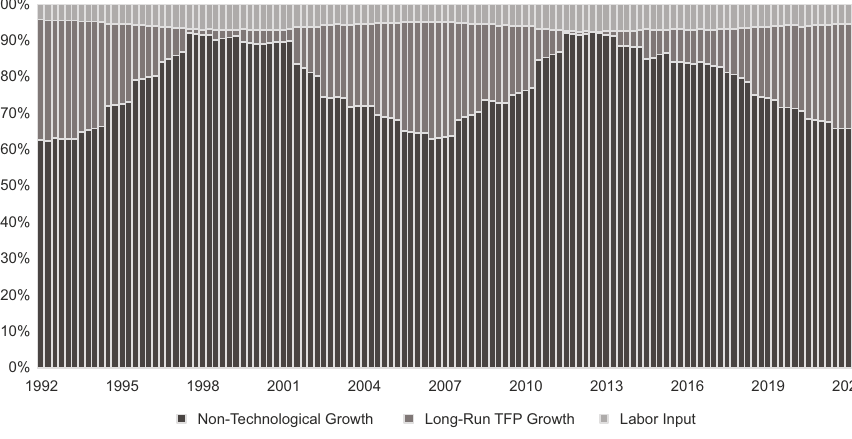
Figure 9. Changes in the time-varying contributions of labor input, technological progress and capital deepening to the